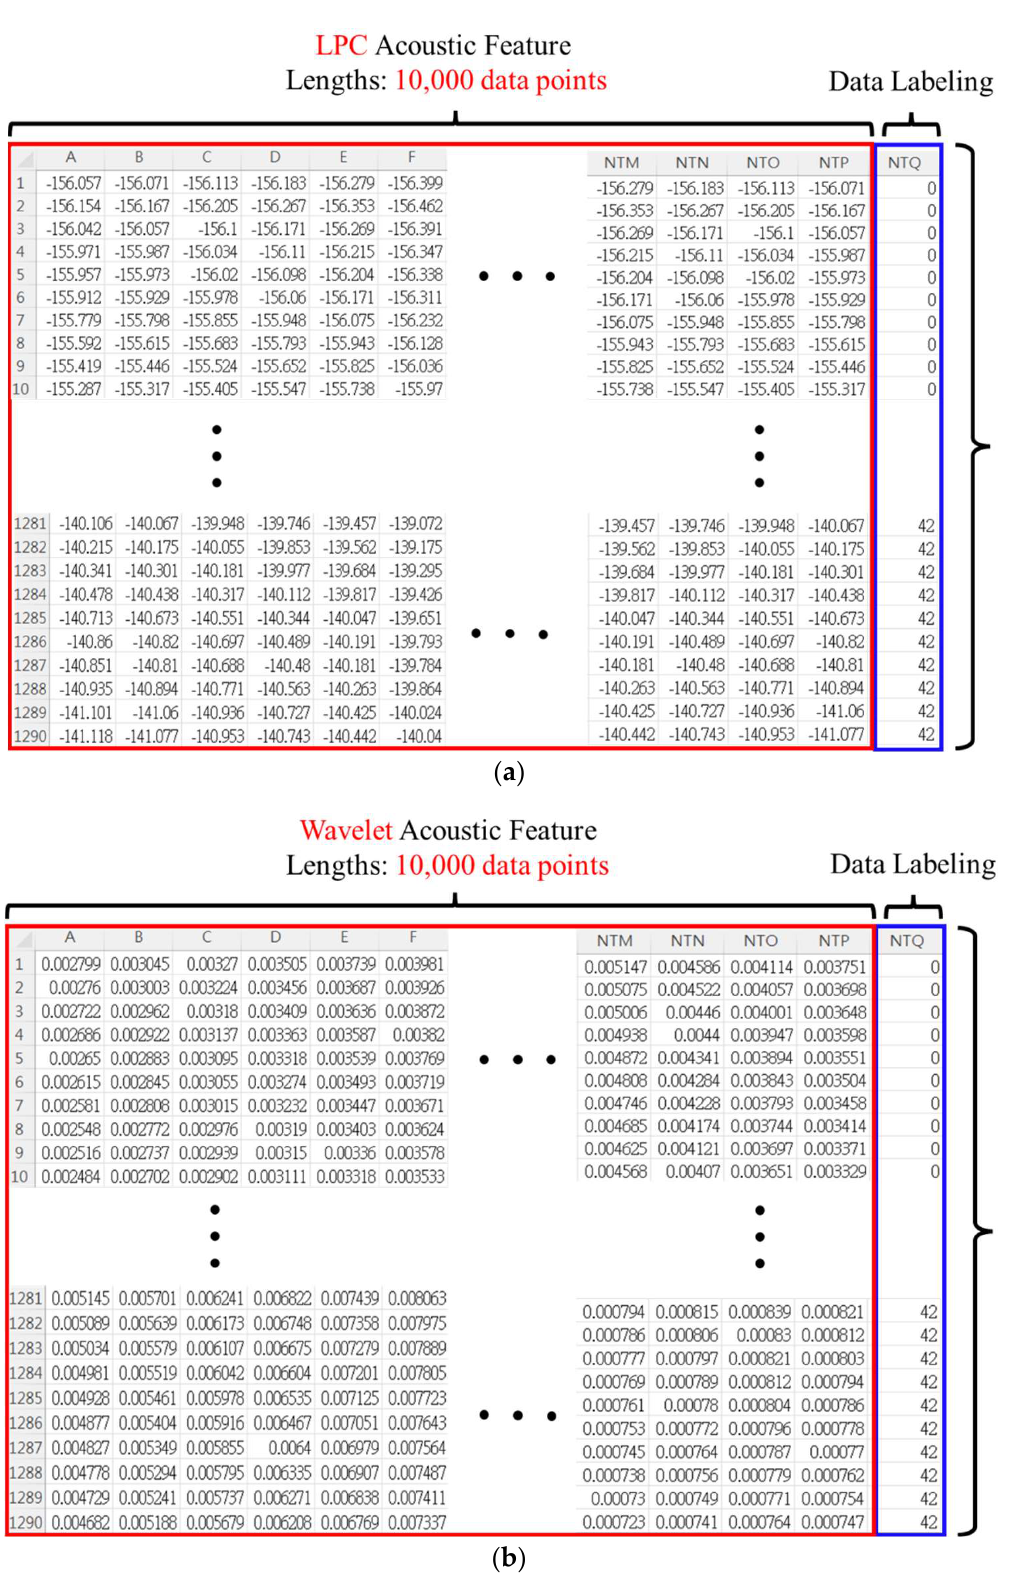
Figure 10. Features of the 43 conditions of the acoustic signals after ( a ) LPC and ( b ) wavelet extrac- tions.